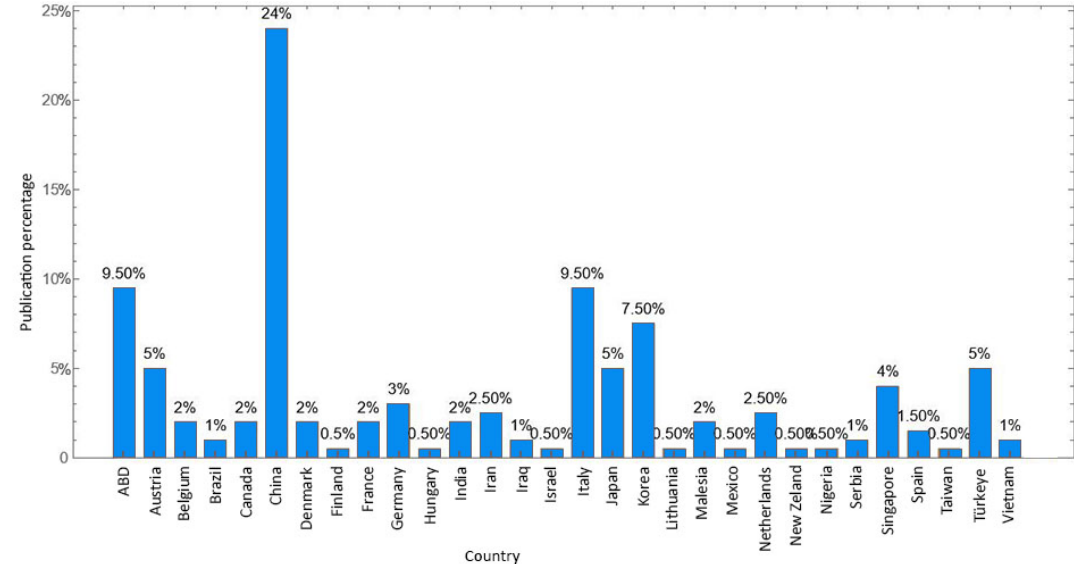
Figure 4 The quantity of articles classified by country